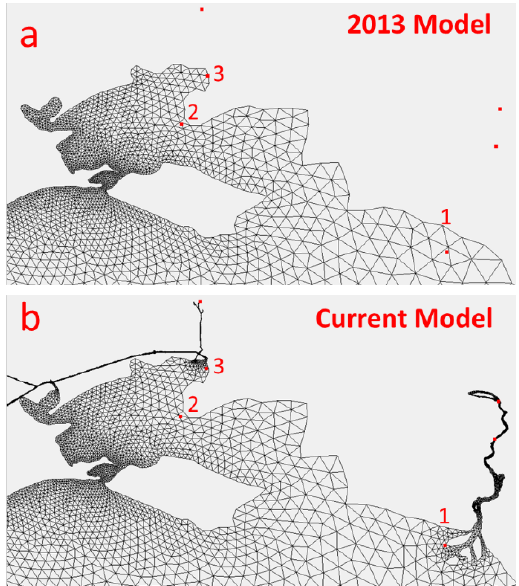
Figure 16. The locations of the three tide stations (“1”, “2”, and “3”) in the western LA region, which were included in both the previous ( a ) and current ( b ) tidal model domains. The coordinates of the tide stations 1, 2, and 3 are [91.3381° W, 29.4496° N], [−91.8800° W, 29.7134° N], and [−91.8800° W, 29.7134° N], respectively. The red dots are the tide stations in the CO-OPS tidal datum data used for this work.